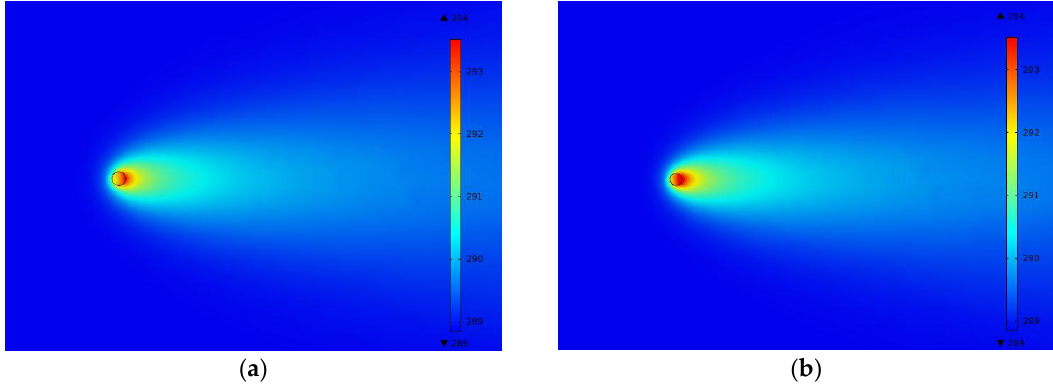
Figure 9. Comparison of analytical solution and numerical analysis results (u = 2.5 × 10 −6 m/s, D/L ratio = 0.025). Temperature increment at ( a ) wall of front side; ( b ) 0.15 m of front side; ( c ) wall of back side; ( d ) 0.15 m of back side; ( e ) 0.30 m of back side; ( f ) 0.50 m of back side.